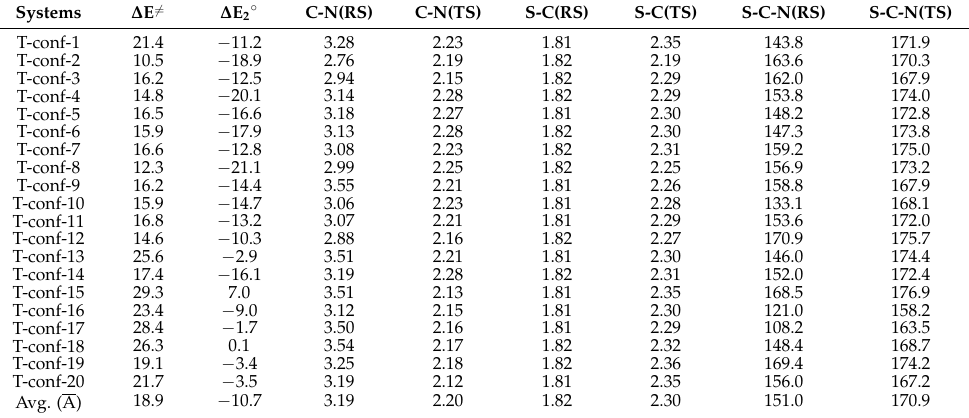
Table 2. Barrier heights ( ∆ E (cid:54) = ), reaction energies ( ∆ E 1 ◦ ) and selected geometric parameters for the conformations at the RS and TS for the methyl-transfer reaction carried out by M3RA. The C atom refers to the carbon from the methyl group of SAM and N to the nitrogen from Lys4 side chain. Energies are in kcal/mol, distances in Å and angles in degrees ( ◦ ). T-conf-N indicates the trimer configuration, where N denotes the sampling window from which it was